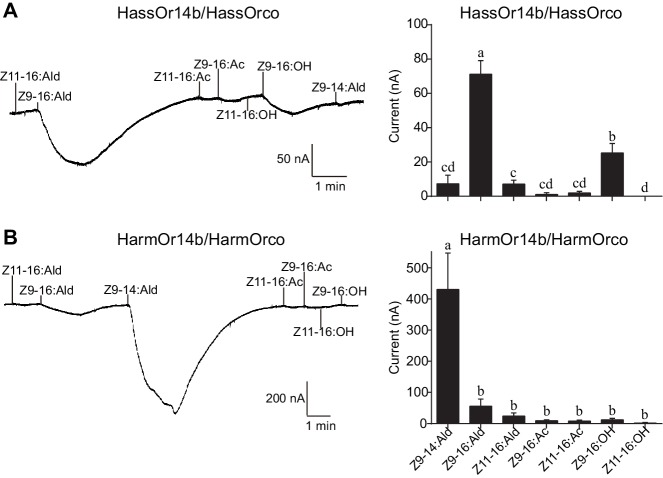
Two-electrode voltage-clamp recordings of Xenopus oocytes with co-expressed HassOr14b/HassOrco, and HarmOr14b/HarmOrco, stimulated with pheromone components and analogs.(A) Inward current responses (left) and response profiles (right) of Xenopus oocytes expressing HassOr14b/HassOrco in response to 10−4 M concentrations of pheromone components and analogs. n = 7 replicates of cells, F = 31.75, p<0.001, one-way ANOVA, Tukey HSD test. (B) Inward current responses (left) and response profiles (right) of Xenopus oocytes expressing HarmOr14b/HarmOrco in response to 10−4 M concentrations of pheromone components and analogs. n = 7 replicates of cells, F = 17.67, p<0.001, one-way ANOVA, Tukey HSD test. Data are presented as mean ± SEM.